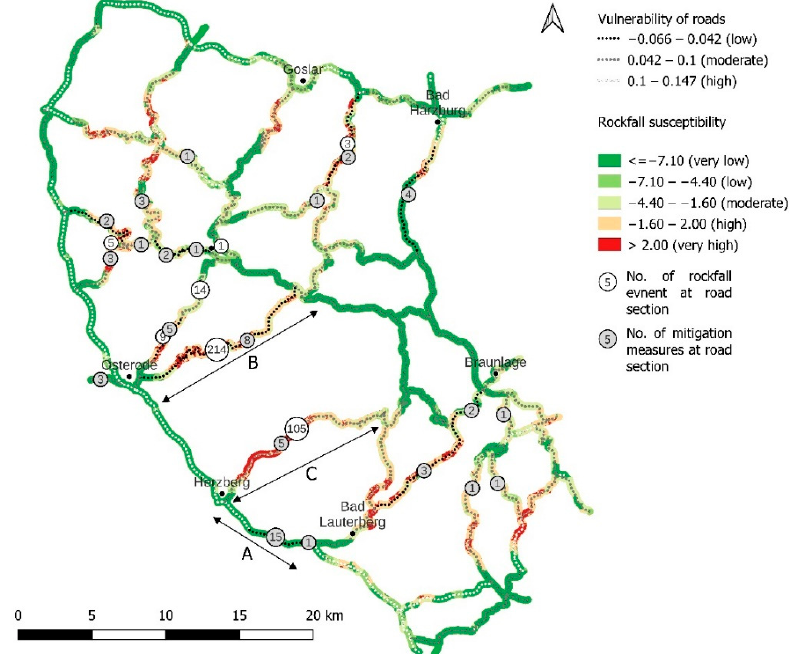
Figure 7. Vulnerability of road sections in the Harz mountains in combination with the modeled landslide susceptibility, number of rockfalls, and mitigation measures at the road